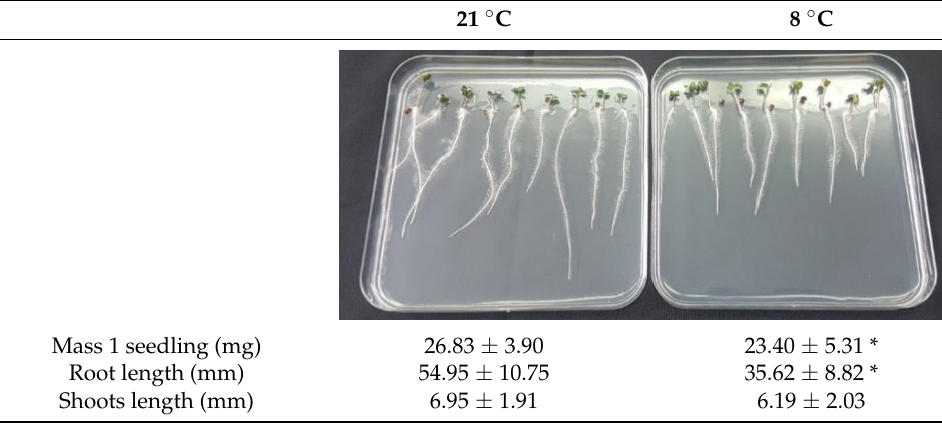
Table 1. Mass per sprout, root and shoots lenght of flat leafe kale ( B. oleracea var. acephala ) sprouts Table 1 . Mass per sprout, root and shoots lenght of flat leafe kale (B. oleracea var. acephala) sprouts grown at 21 ◦ C (control) and 8 ◦ C. Value marked with asterisk (*) are significantly different from the grown at 21 °C (control) and 8 °C. Value marked with asterisk (*) are significantly different from the control at p < 0.05. control at p < 0.05.